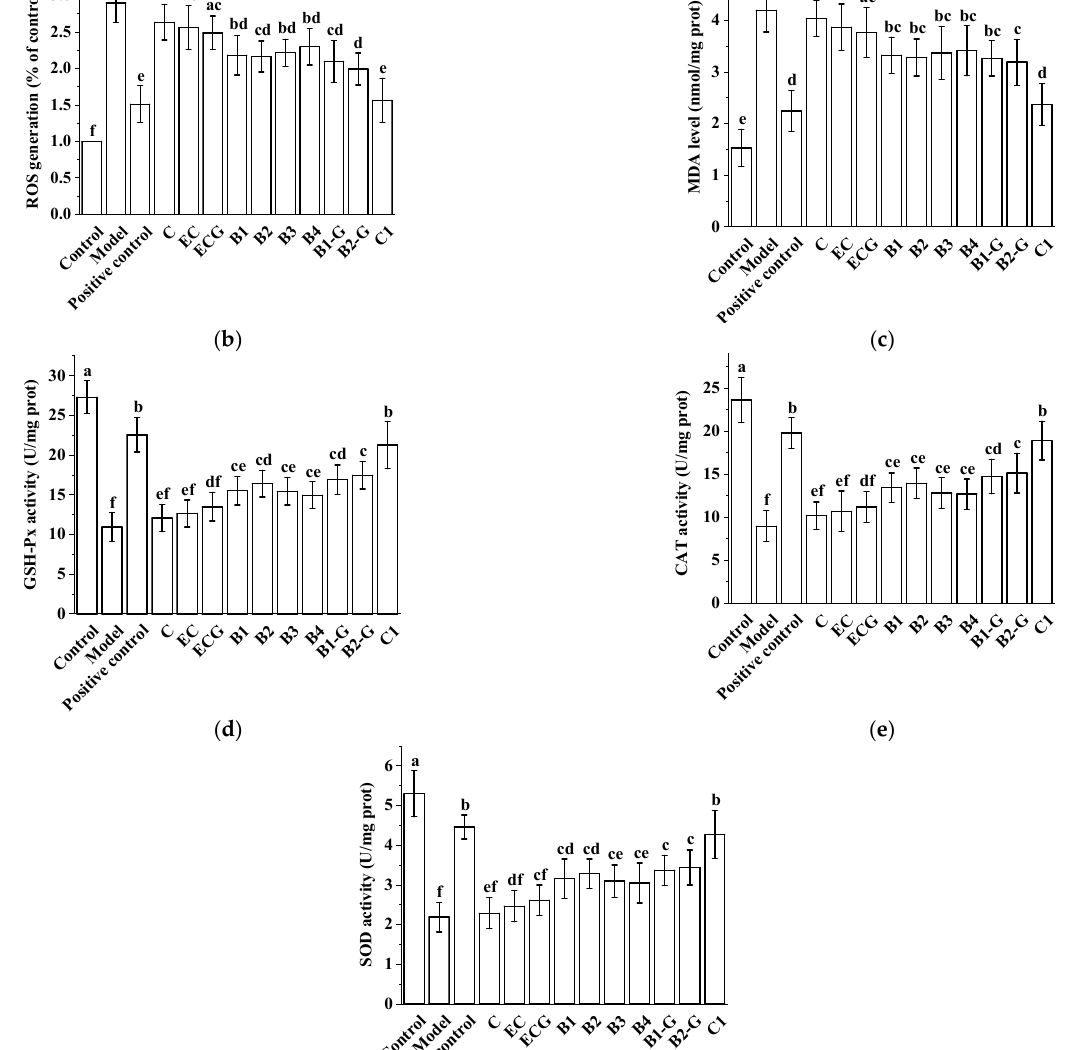
Different procyanidin treatments can up-regulate the expression of Nrf2 and the related genes NQO1 and HO-1, which are downstream of the Nrf2/ARE pathway in H 2 O 2 - induced zebrafish. There was no significant difference between the procyanidin monomer (C, EC, ECG) treatment groups and the model group (Figure 8, p > 0.05); however,